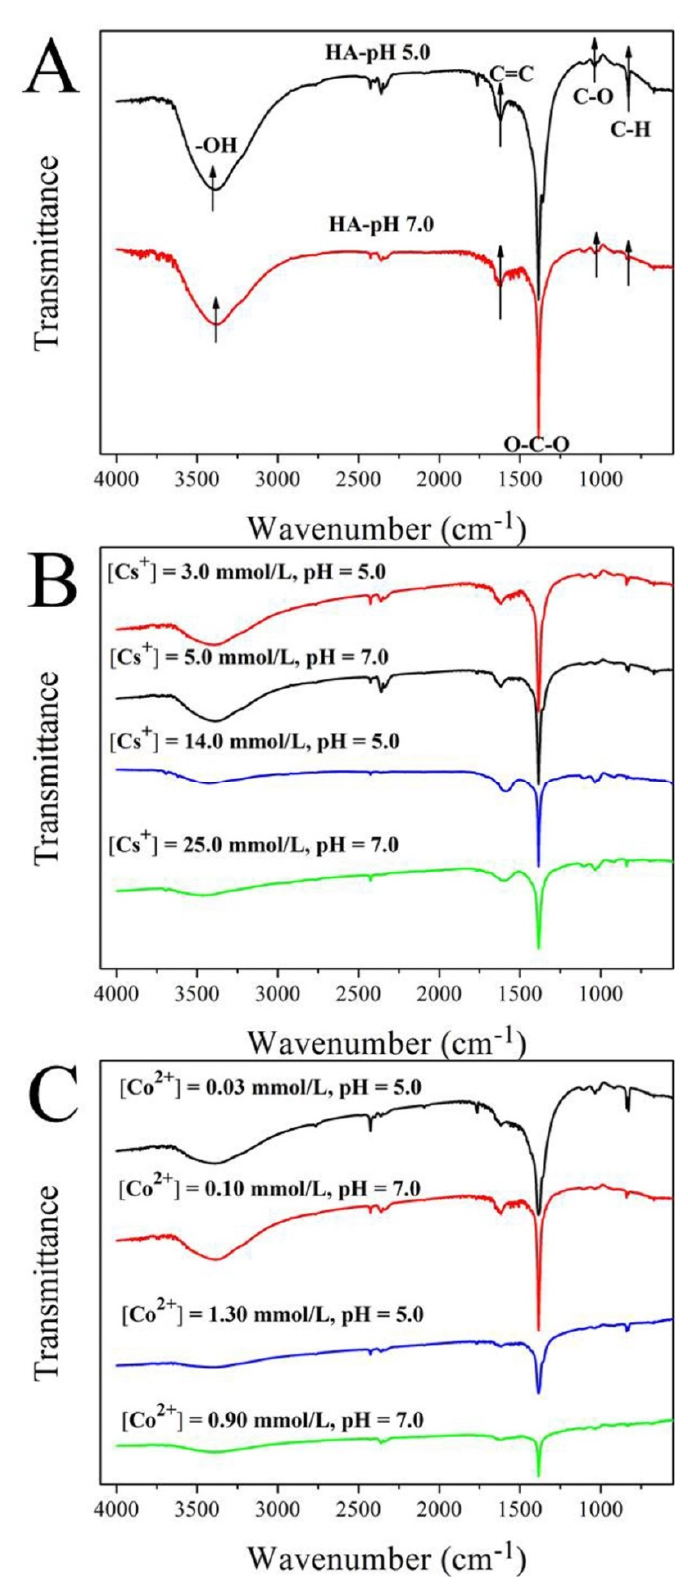
Figure 3. FT − IR spectra of HA before ( A ) and after ( B , C ) interaction with Cs + or Co 2+ metal ion after long aggregation time at pH 5.0 and 7.0.